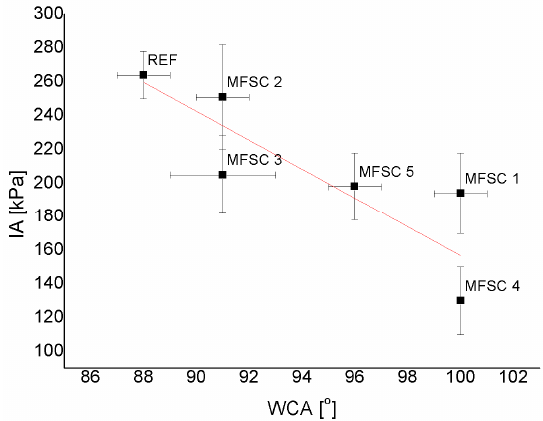
Figure 7. The relationship between ice adhesion and water contact angle.